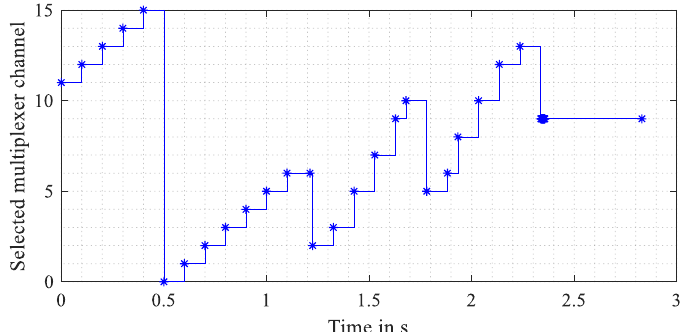
Figure 25. Multiplexer channels when C9 is placed on an arbitrary position.